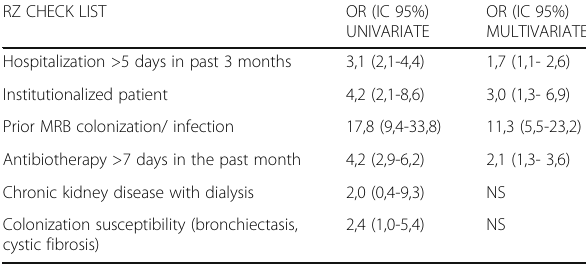
Table 13 (abstract A19). Risk Factors for MRB